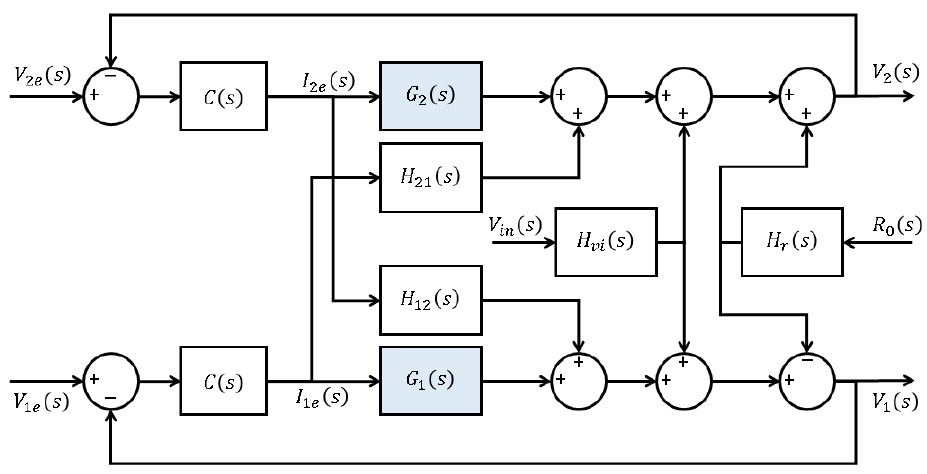
Figure 5. Block diagram of the outer voltage controllers.